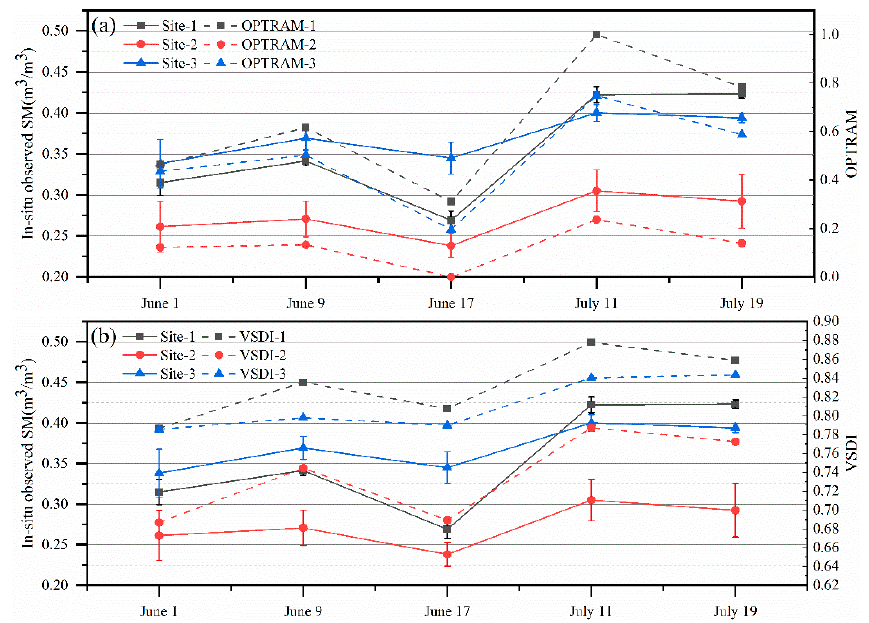
Figure 6. Temporal variation of the in situ observed SM, ( a ) OPTRAM and ( b ) VSDI indexes at three sites during the SMAPVEX16_Manitoba experiment, where the site ID of Sites 1, 2, and 3 are 31, 210, and 221, respectively.